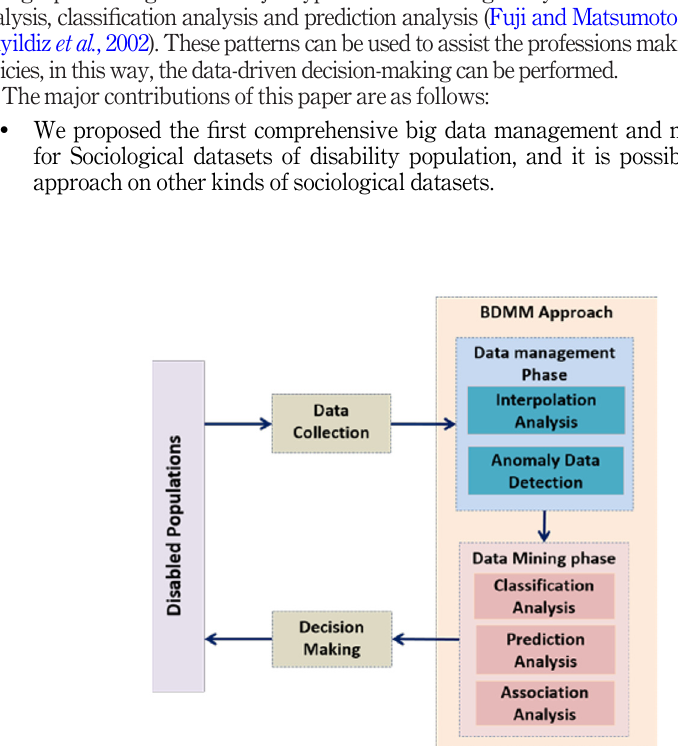
Figure 1. The fl ow diagram